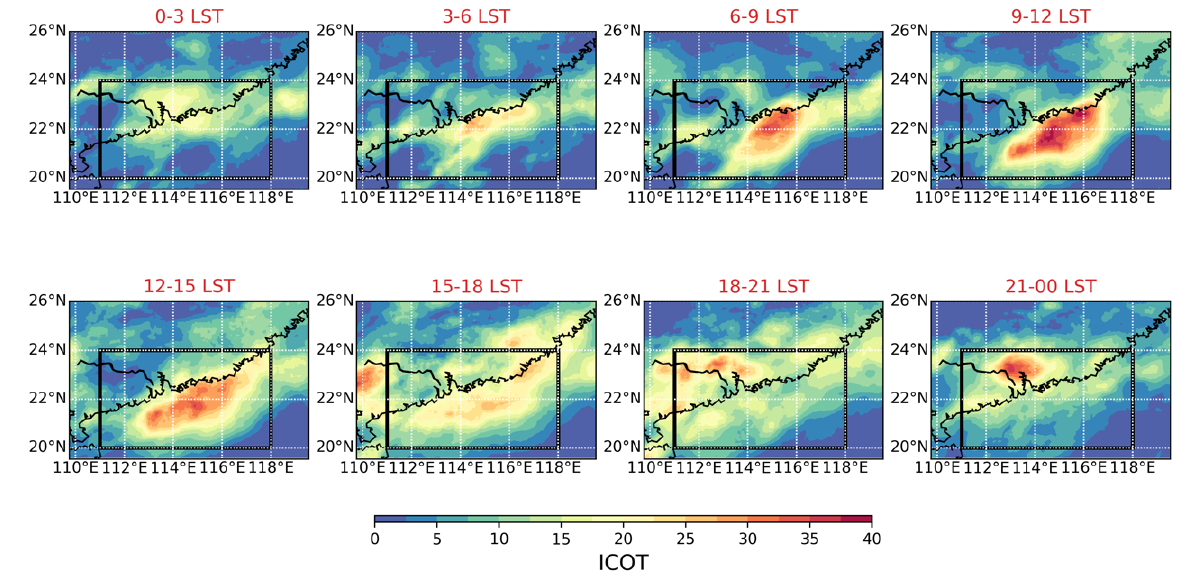
Figure 4. Same as in Figure 2 but for mean ice cloud optical thickness (ICOT) retrieved using the deep neural network (DNN) model by [6], with Himawari-8 infrared measurement as input.